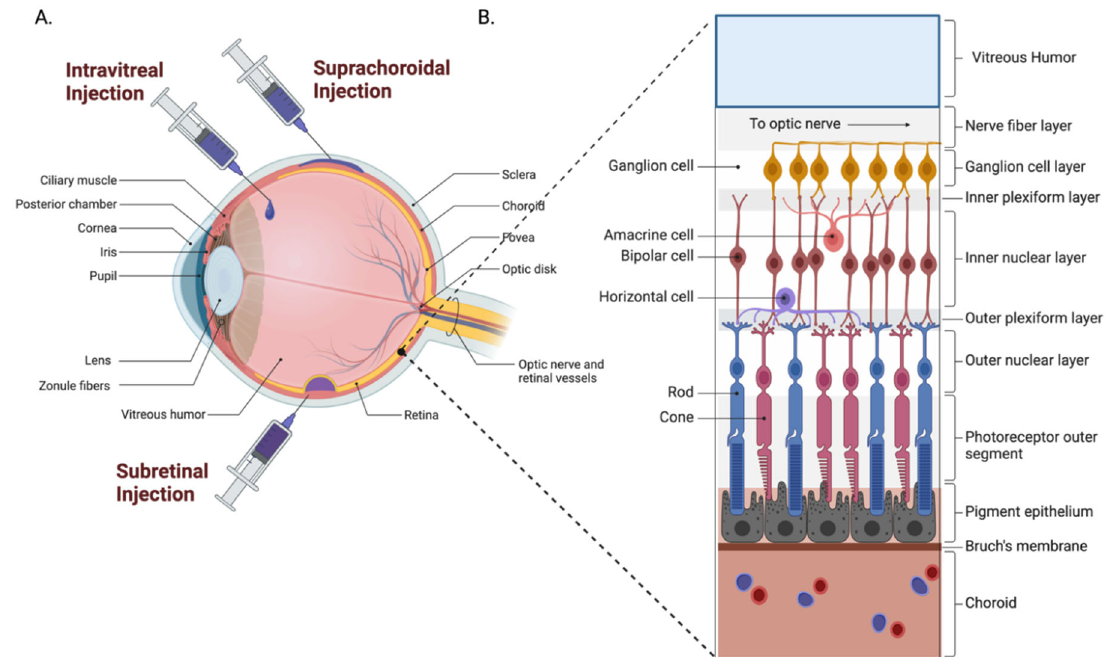
Figure 6. Drug administration routes to the posterior anatomy of the eye. ( A ) Intravitreal injections administer the drug directly to the vitreous humor. Suprachoroidal injections deliver directly into the suprachoroidal space. Implants are non-biodegradable systems often anchored to the sclera or injected into the vitreous that release drugs at a predetermined rate. Subretinal injections target the subretinal space or the area directly between retinal pigment epithelium (RPE) cells and photoreceptors. ( B ) The posterior anatomy of the eye consists of the vitreous humor and the retina, which contains layers of terminally differentiated cells used for light perception.